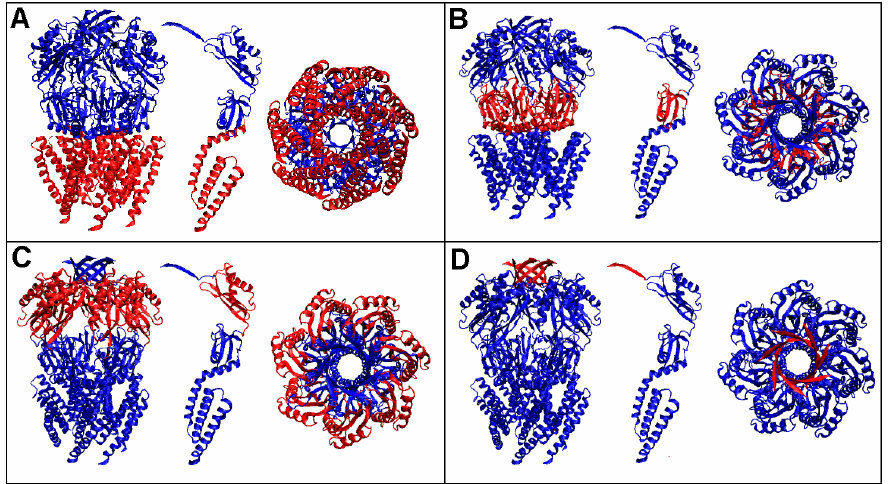
Figure 3. The arrangement of domains in HpMscS (4HW9) and their identification used in the present work. Two perspectives and an appropriately oriented structure of a single chain in the central part are shown. ( A ) Domain 1, defined as DD1 if analyzed as a set of seven fragments of the chain and D1 if analyzed as an independent structural unit in a single chain (central position in each of the windows). ( B ) Domain 2, defined as DD2 if analyzed as a set of seven fragments of the chain and D2 if analyzed as an independent structural unit in a single chain. ( C ) Domain 3, defined as DD3 if analyzed as a set of seven fragments of the chain and D3 if analyzed as an independent structural unit in a single chain. ( D ) Domain 4, defined as DD4 if analyzed as a set of seven frag- ments of the chain and D4 if analyzed as an independent structural unit in a single chain. Table 2. A set of parameter values describing the statuses of the complexes, chains, and domains of proteins representing the mechanosensitive channels of HpMscS and EcMscS, treated as compo- nents of the complex and as individual structural units. HpMscS (4HW9)-CLOSED